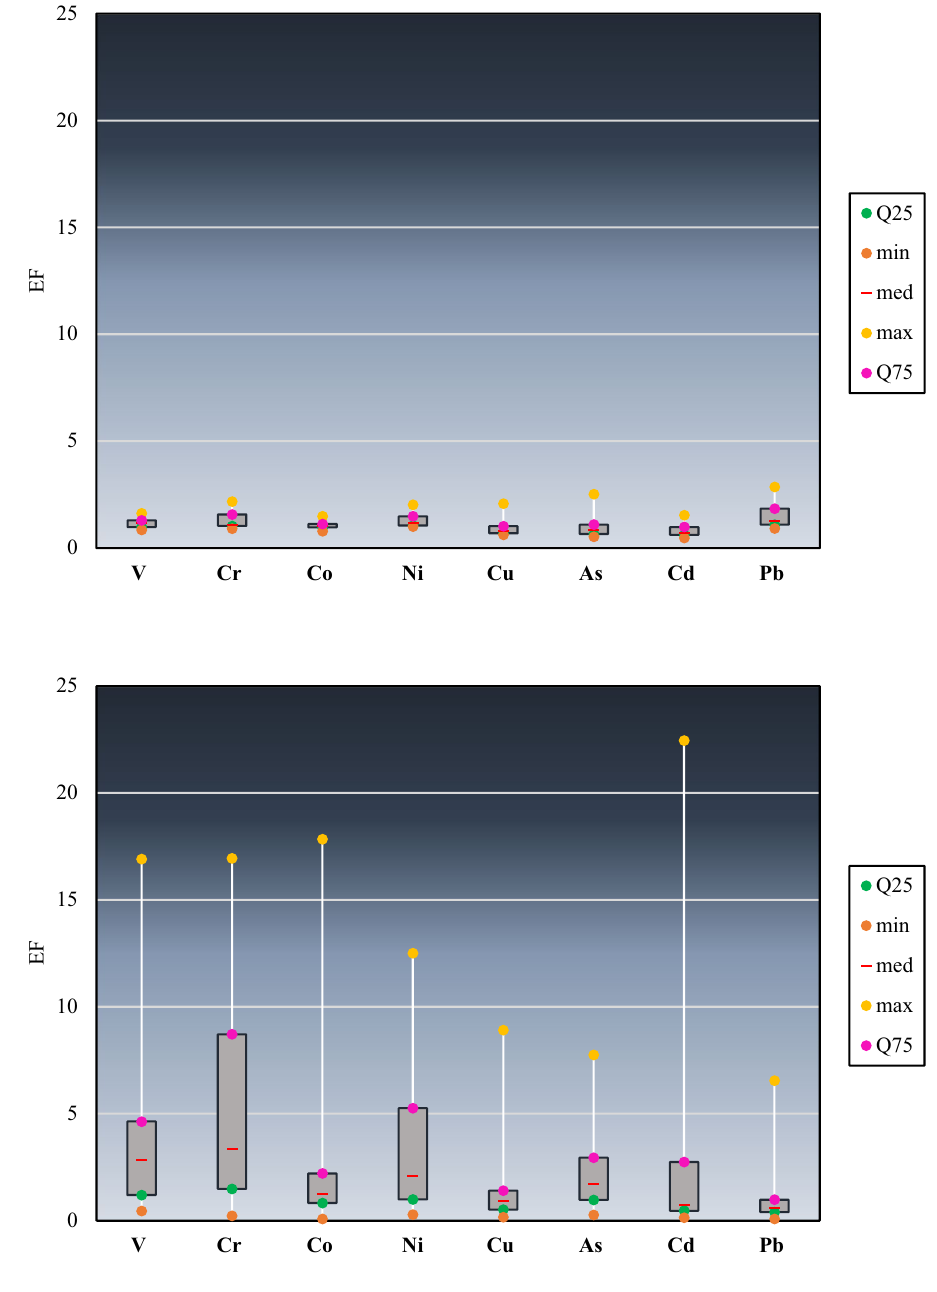
Fig. 10 Enrichment factor (EF) for Appian Way Regional Park